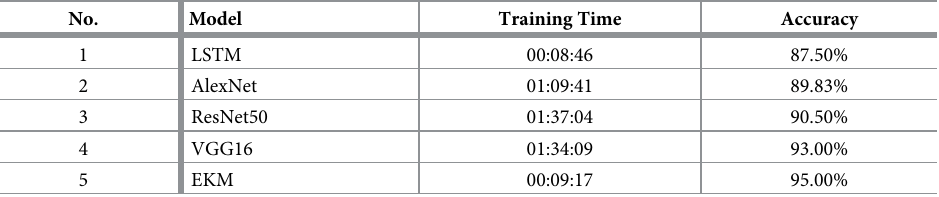
Table 4. Experiment 3: Comparison of EKM with other CNN and LSTM models, all applied to the EMIR dataset.